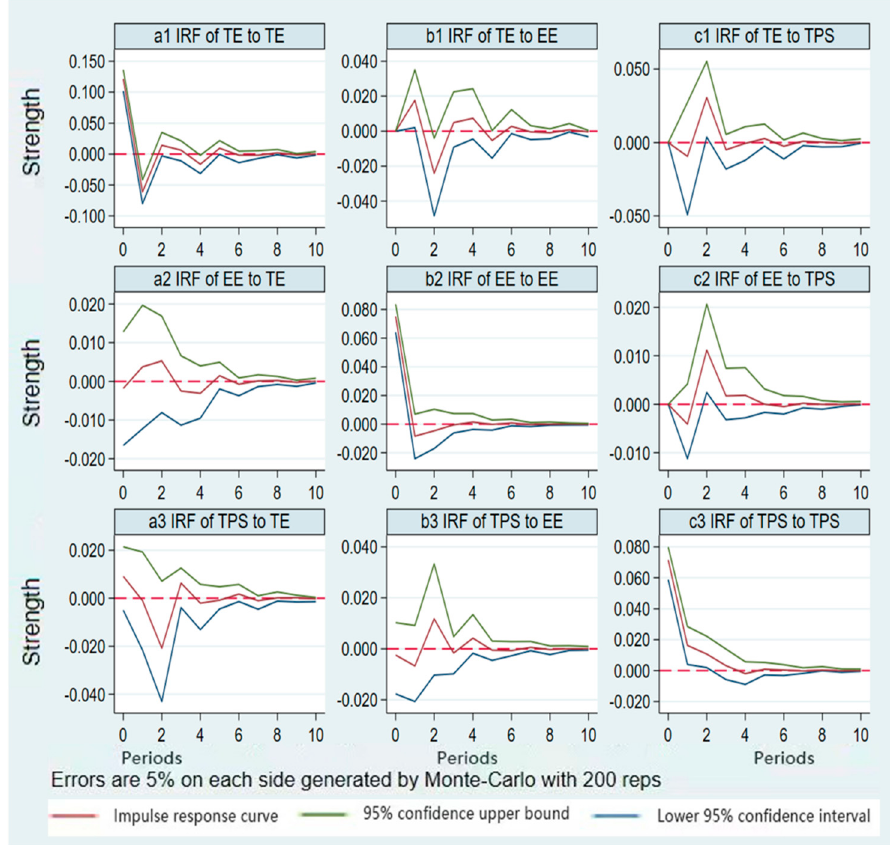
Figure 5. Impulse Response Diagram of Tourism-Ecological Environment-Public-Service.